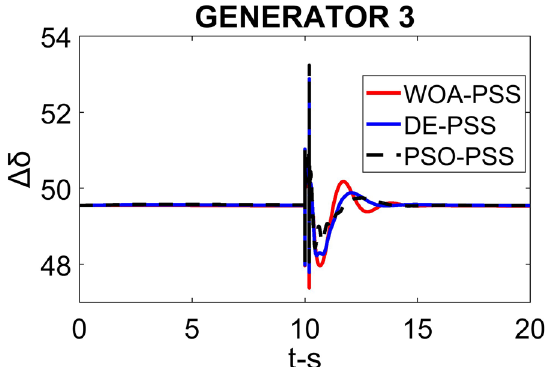
Fig. 19 delta deviation of G3 under 3- φ fault at t = 10 s